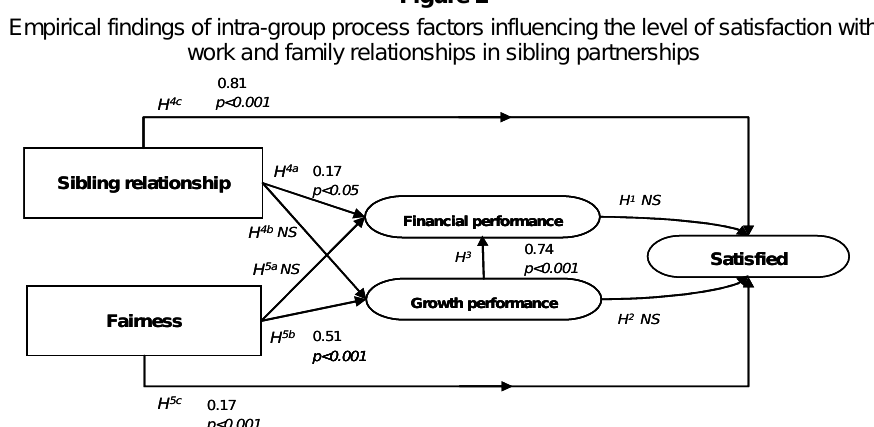
Empirical findings of intra-group process factors influencing the level of satisfaction with work and family relationships in sibling